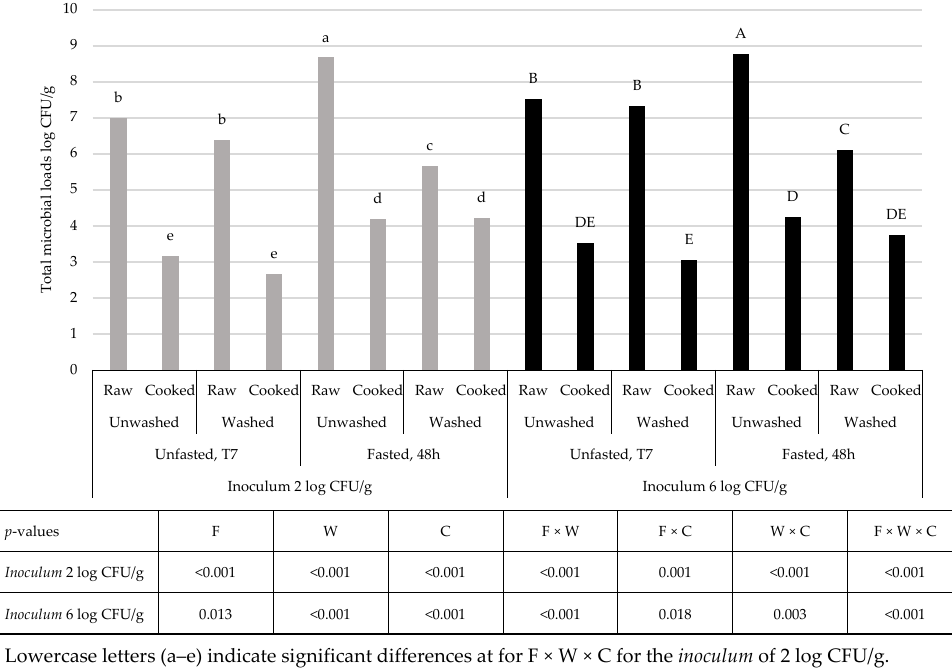
Figure 4. Effects of fasting (F), washing (W), and cooking (C) on the total microbial loads of the larvae reared in the substrates inoculated with Listeria monocytogenes .